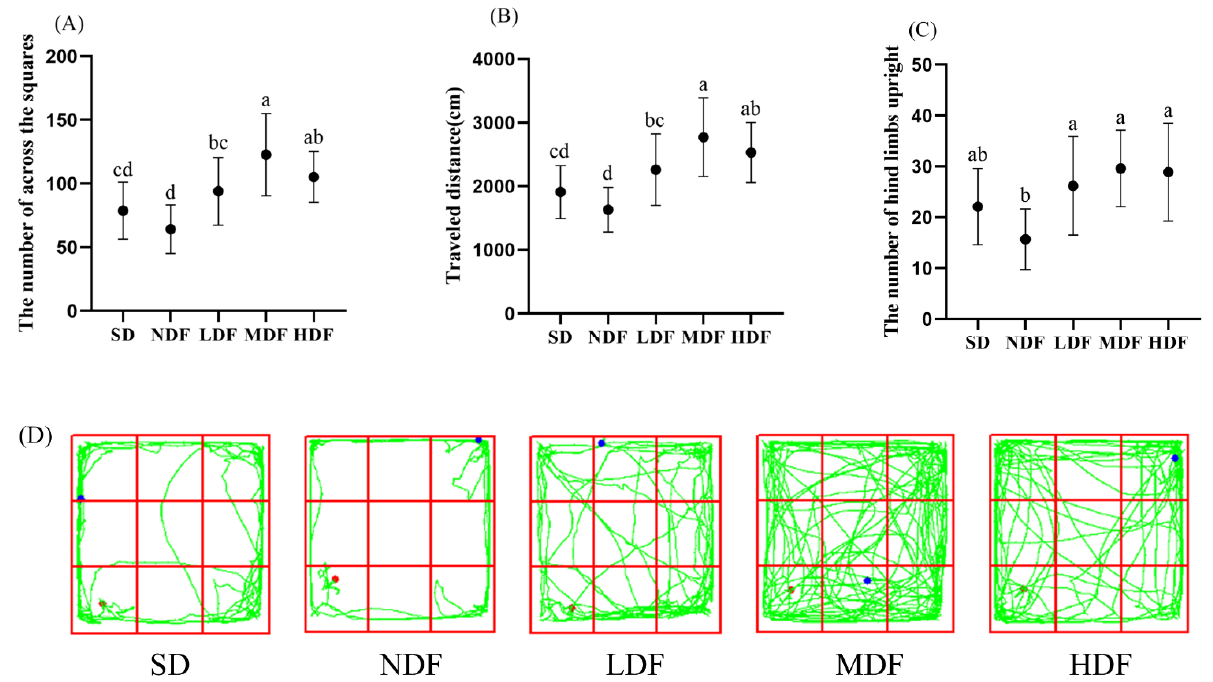
Figure 1. Effect of CDFC on exploration ability of aging mice: ( A ) the number of across the squares; ( B ) traveled distance; ( C ) the number of hind limbs upright. Different superscript letters denote a significant difference in the same index ( p < 0.05). ( D ) representative traces of mice in different groups. (the green line is the trajectory; the red dot is the starting point; the blue dot is the ending).